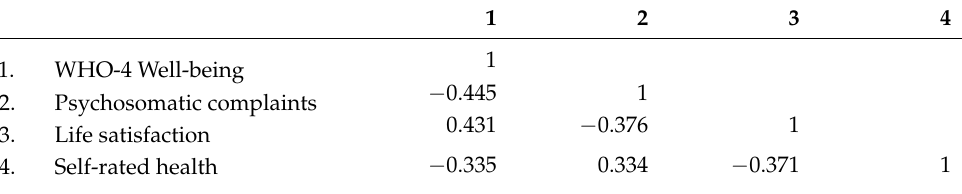
Table 6. Convergent validity: correlation coefficients using aggregated data (WHO-4) ( N = 74,071).